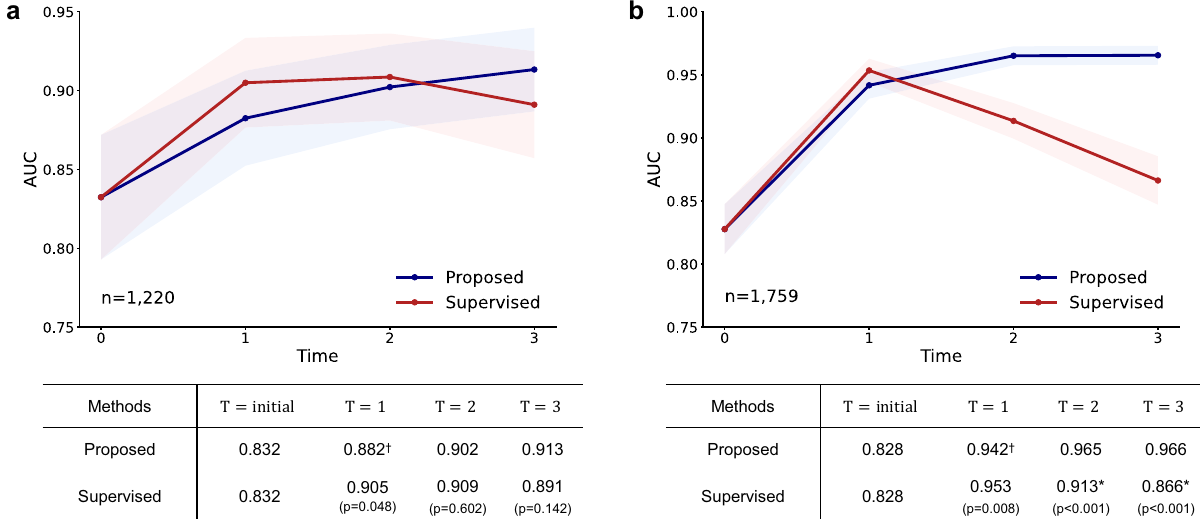
Fig. 7 Other CXR diagnosis results including pneumothorax and coronavirus disease 2019 (COVID-19) diagnoses. a When applied for pneumothorax diagnosis, the model trained with the proposed framework improved gradually over increasing time T , while the supervised model showed the sign of over fi tting at later T . b Likewise, the model trained with the proposed framework outperformed the supervised model for the COVID-19 diagnosis task, which was more prominent under the increasing amount of unlabeled data. Data are presented with calculated area under the receiver operating characteristics curves (AUCs) in the study population (center lines)±95% con fi dence intervals calculated with the DeLong's method (shaded areas). The AUCs of the proposed method and the supervised learning method were compared at each time point T with the DeLong test to evaluate statistical signi fi cance, except for the T = initial where the two methods start from the same baseline. † denotes statistically inferior performance, while * denotes statistically signi fi cant superiority of the proposed framework ( p < 0.050). All statistical tests were